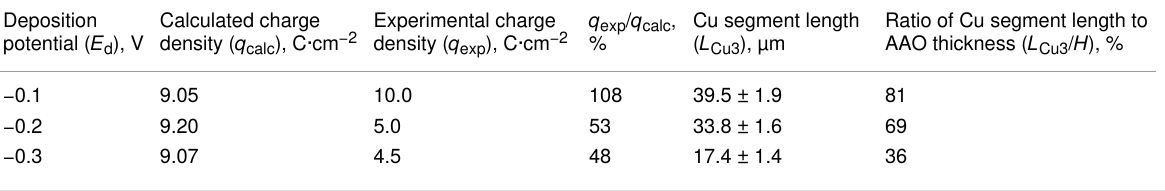
Table 2: Completeness of the AAO template filling during the electrodeposition of the third Cu